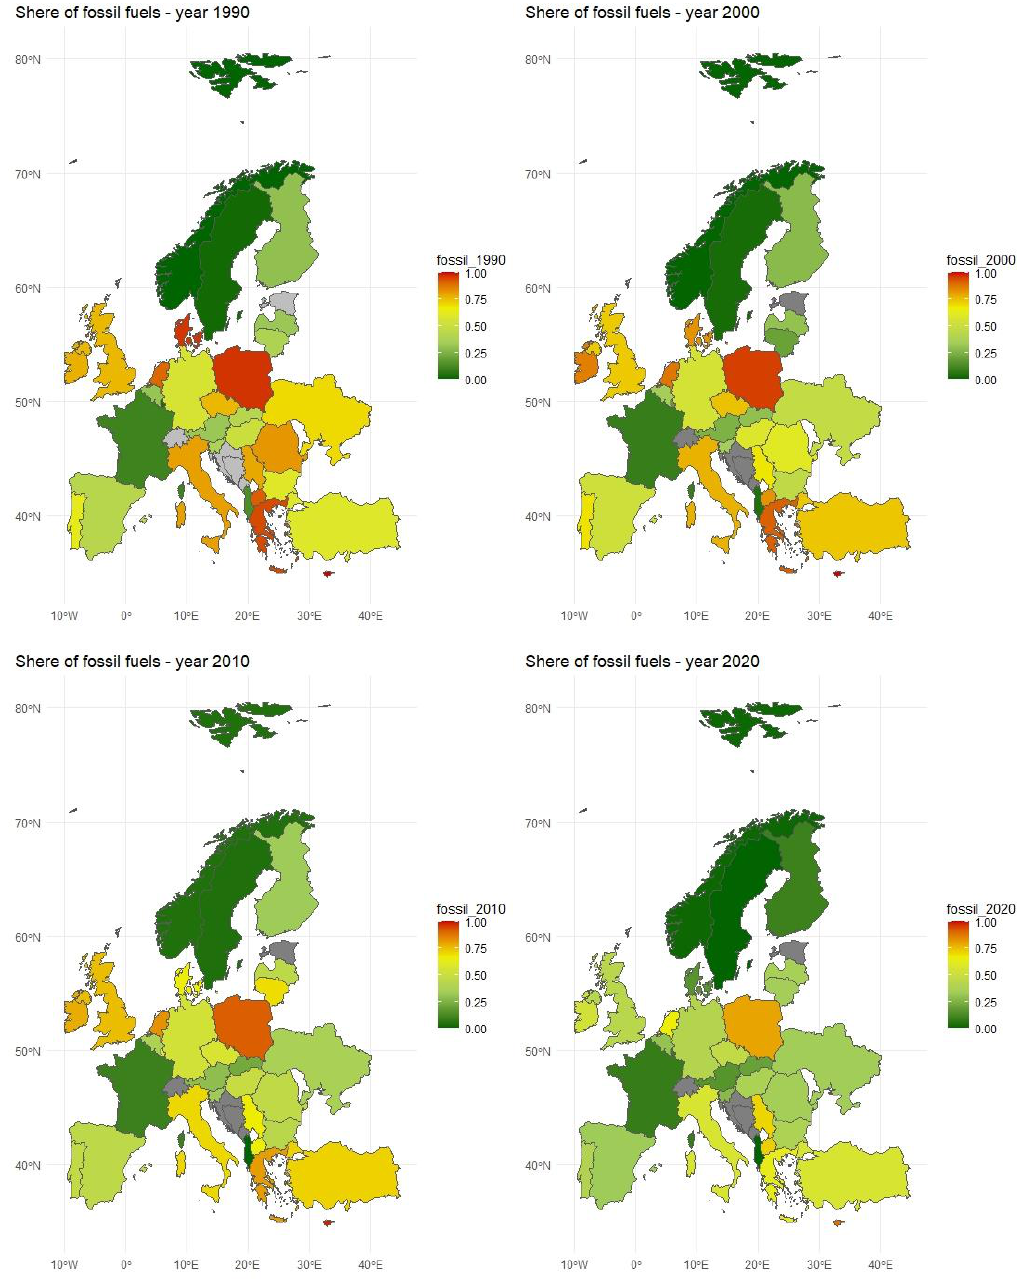
Figure 2. Share of electricity generated from fossil fuels in the years 1990 – 2020. In 2000, the group of countries with over a 50% share of renewable sources in their total electricity production was joined by Croatia and Sweden. The Croatian electricity production system has a unique topology, resulting from the fact that it was established in the period when Croatia was part of a larger country (Yugoslavia), which comprised all the neighboring countries (i.e., Serbia, Bosnia and Hercegovina, and Slovenia). As a result, the Croatian system has a very high interconnection capacity, and the level of import is approx. 20 – 30% of the total energy consumption. Due to the geographical and natural conditions, the production of electricity in Croatia is characterized by very high seasonality, with high peaks in the southern regions during the summer tourist season. Most electricity output comes from hydropower plants (approx. 40% to 50%), which are located along the coast and in the northern region of the country. Slightly less electricity (20% to 30%) is generated by thermal power stations located in the northern and eastern